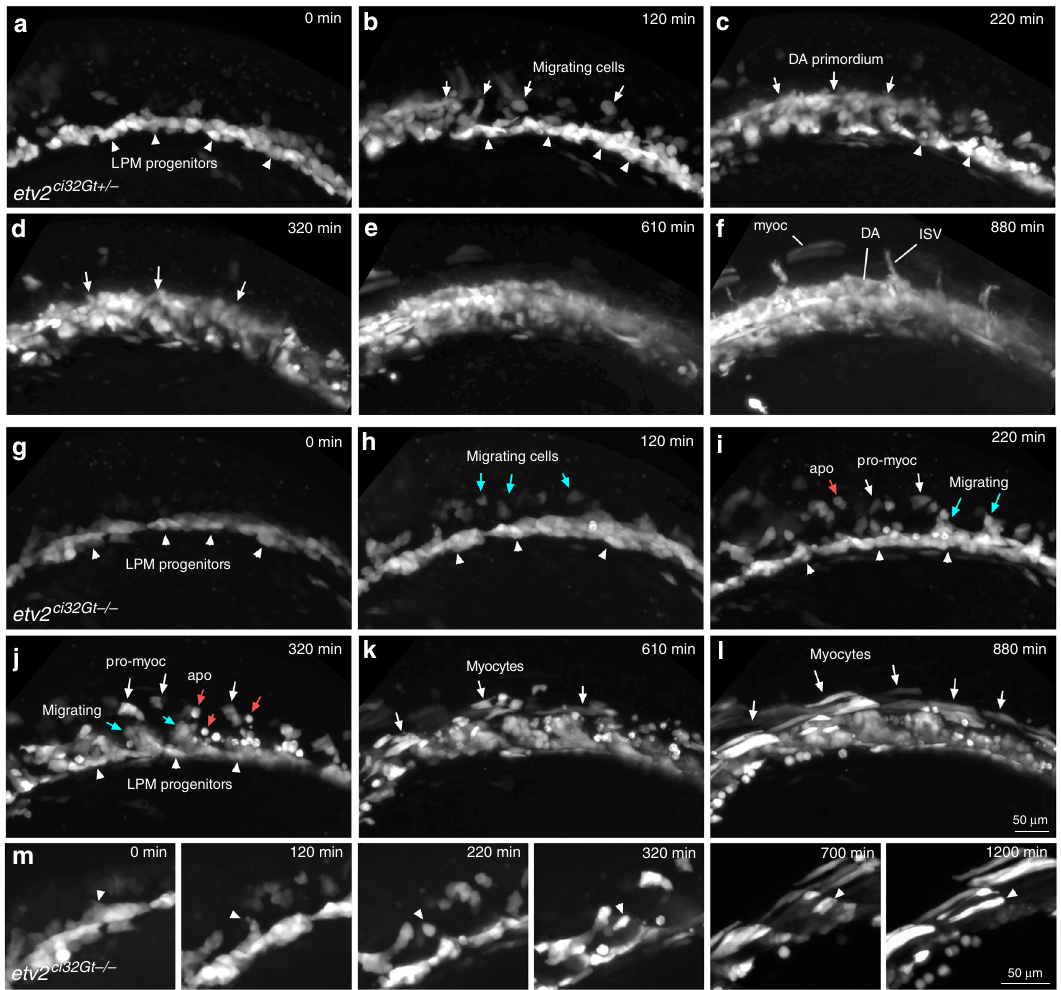
Fig. 4 Time-lapse imaging of cell migration in etv2 ci32Gt embryos starting at the 9 – 10-somite stage. Lateral view is shown, anterior is to the left. a – f In etv2 ci32Gt + / − ; UAS:GFP embryos, bilaterally located vascular and hematopoietic progenitors within the lateral plate mesoderm (LPM, arrowheads) migrate toward the midline and coalesce into the axial vasculature (arrows). Note that some cells remain in the lateral position and elongate into muscle cells (myoc). DA progenitors of the dorsal aorta, ISV intersegmental vessels. Time frames are selected from the Supplementary Movie 1. g – l In etv2 ci32Gt − / − ; UAS:GFP embryos, cells initiate migration (blue arrows) but fail to coalesce into the axial vasculature. Instead, many cells either undergo apoptosis (apo, red arrowheads point to round apoptotic cells) or differentiate into myocytes (white arrows, myoc). Time frames are selected from the Supplementary Movie 3. m Higher magni fi cation view showing differentiation of a GFP + progenitor cell initially positioned in the LPM into a myocyte (arrowhead points to the same cell). Note that the cell migrates dorsally from the LPM into the somite and then elongates as it undergoes differentiate into the muscle. Time frames are selected from the Supplementary Movie 4. Representative embryos are shown out of the total of seven heterozygous and four homozygous etv2 ci32Gt ; UAS:GFP embryos that were imaged in two replicate